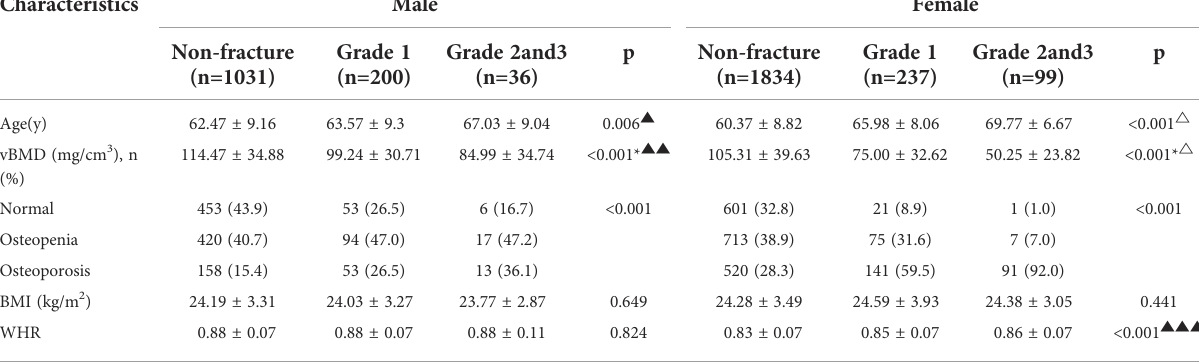
TABLE 2 Characteristics of eligible participants by gender and vertebra fracture grades identi fi ed by Genant ’ s semi-quantitative criteria. Characteristics Male Female Non-fracture